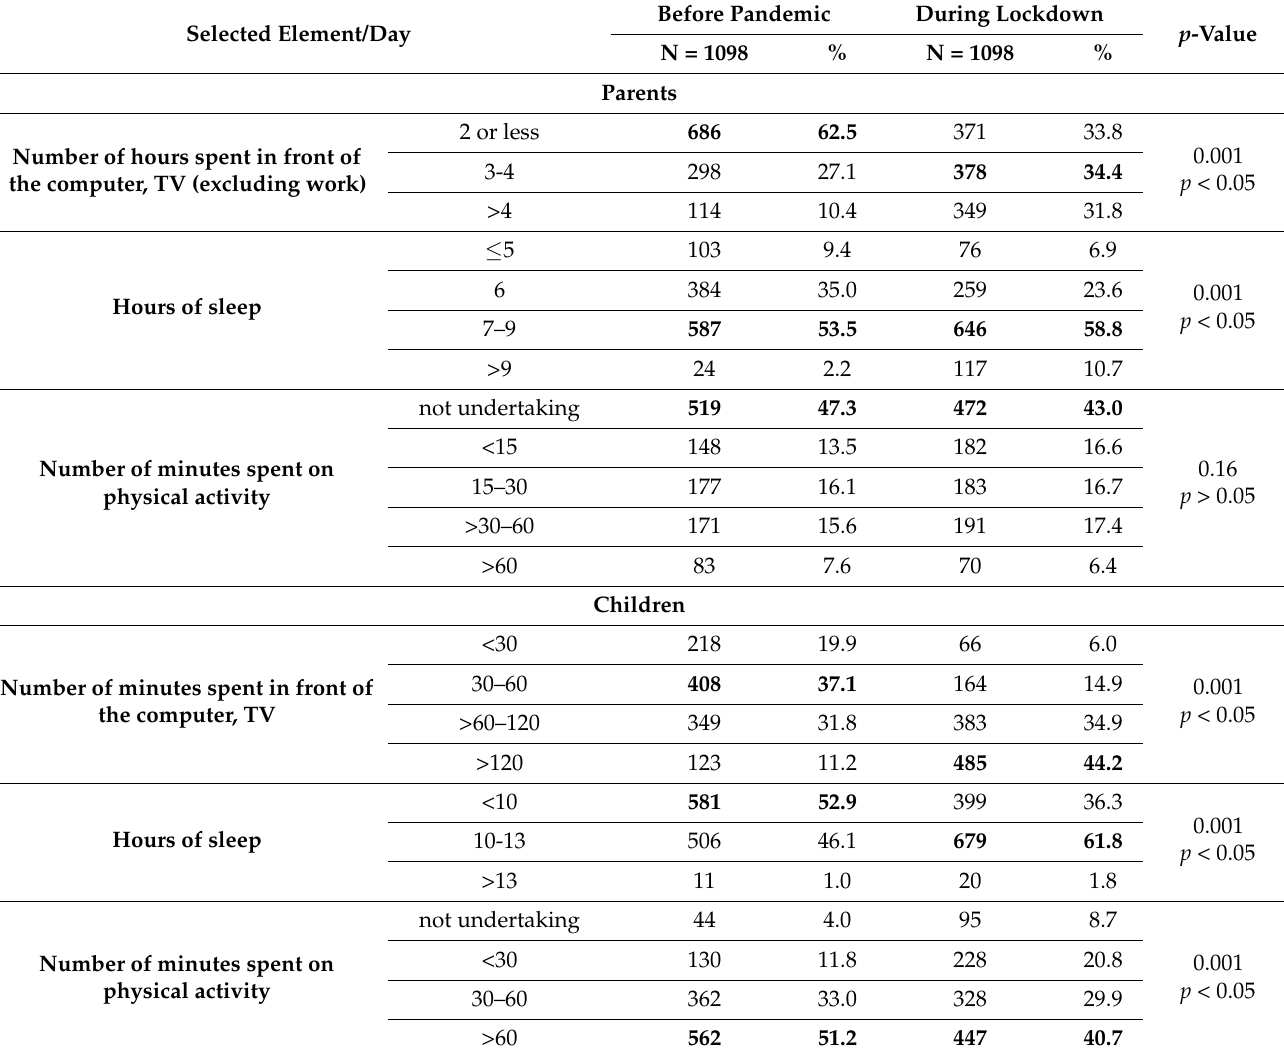
Table 4. Selected aspects of parents’ and children’s